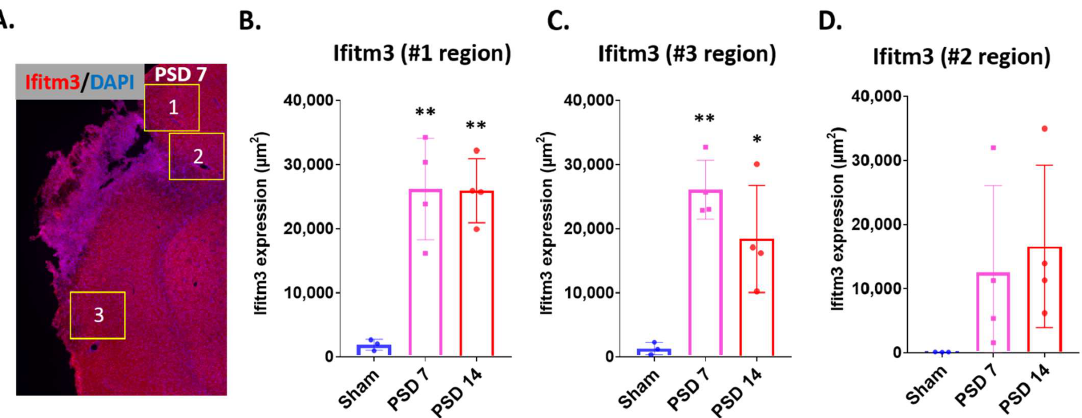
Figure 2. Increased expression of IFITM3 was found in the peri-infarct cortex. At 1 week and 2 weeks after stroke, brains were isolated and IFITM3 immunostaining was performed with the brain